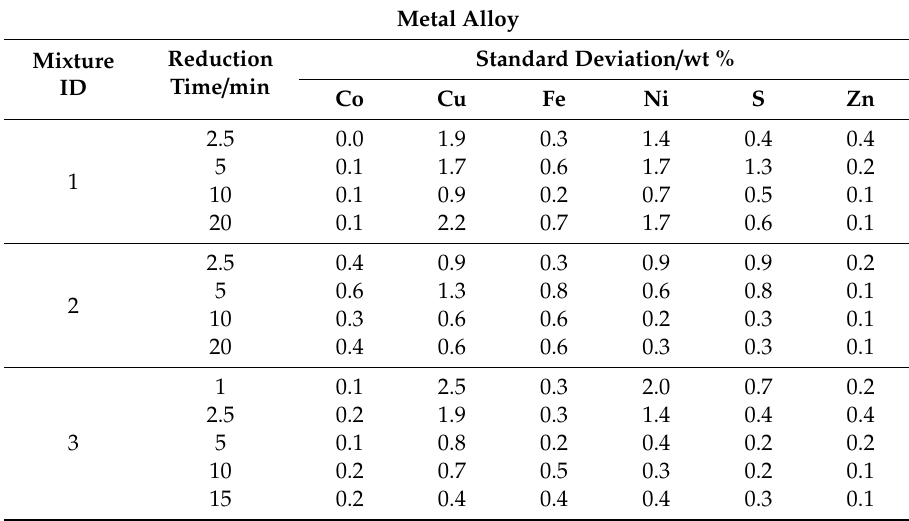
Table A4. Standard deviations (1 σ ) of elemental concentrations in the metal